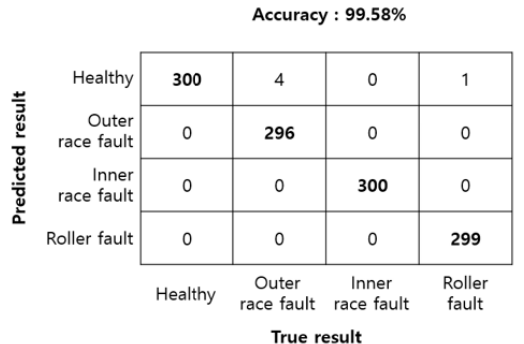
Figure 11. Confusion matrix of the classification result.